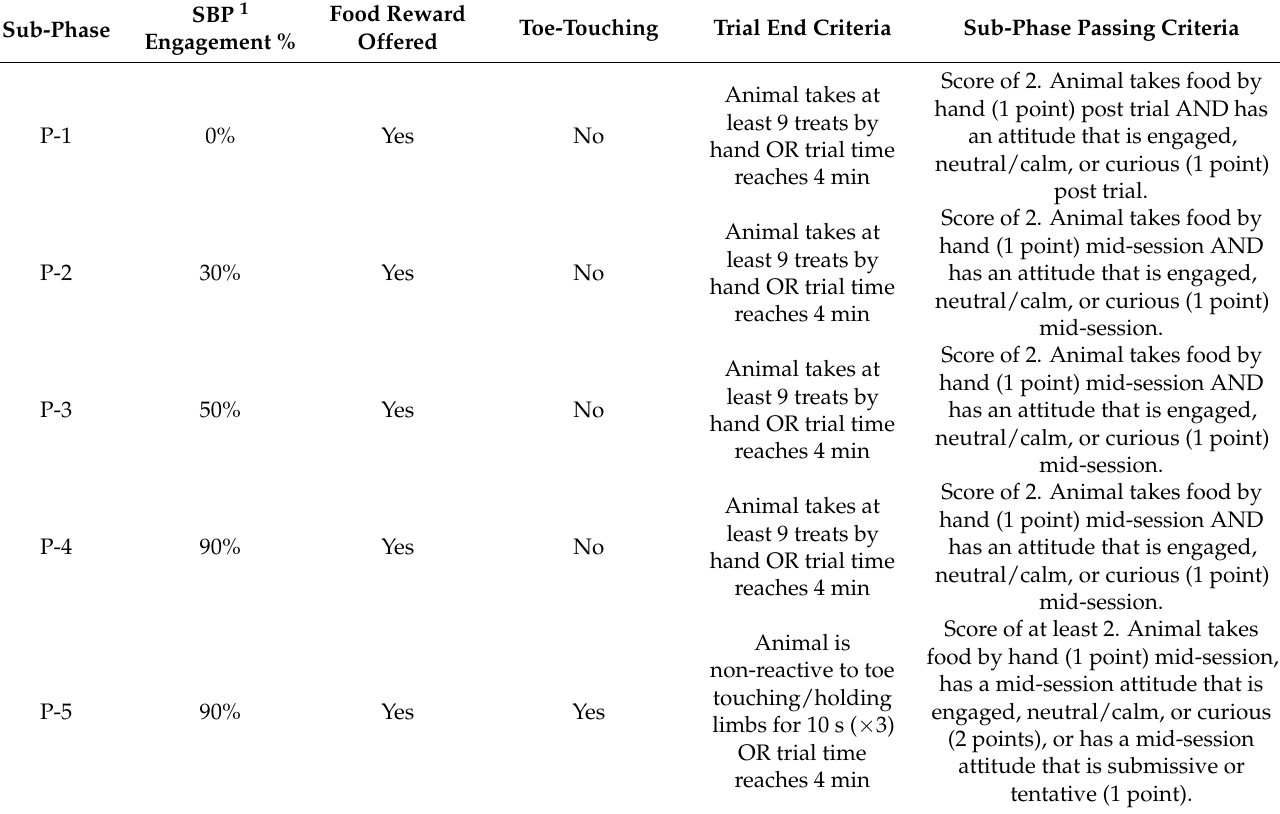
Table 2. Training Details for